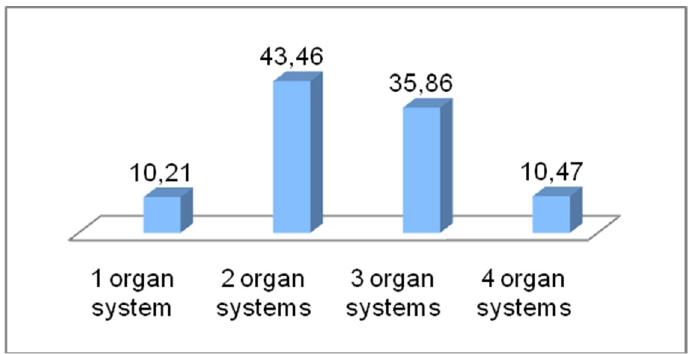
Figure 4. % of case anaphylaxis with 1, 2, 3 or 4 affected organ systems (in the whole group).